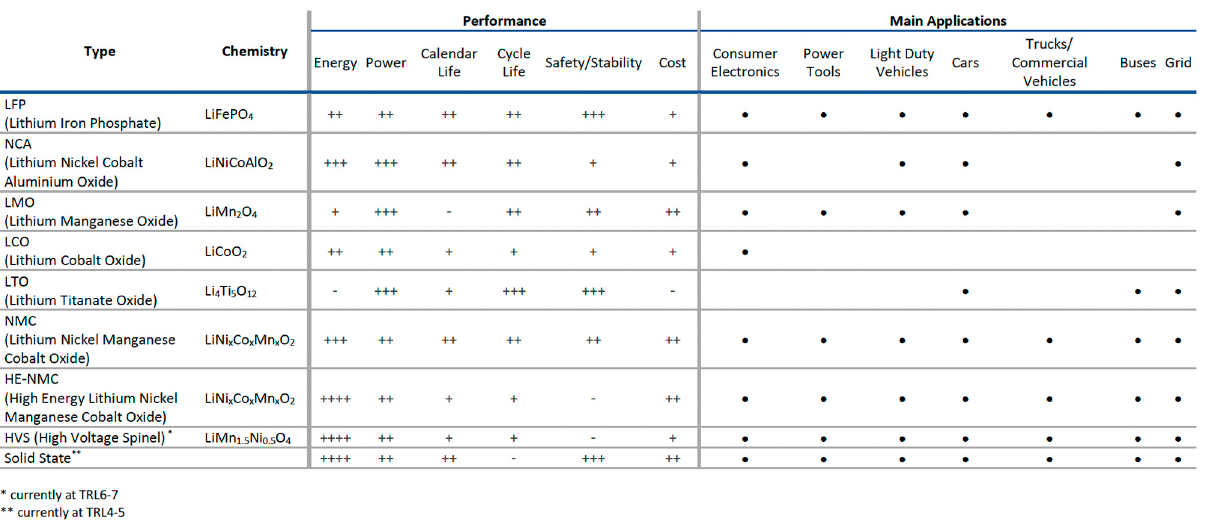
Figure 1. Li-ion battery overview (TRL = technology readiness level).